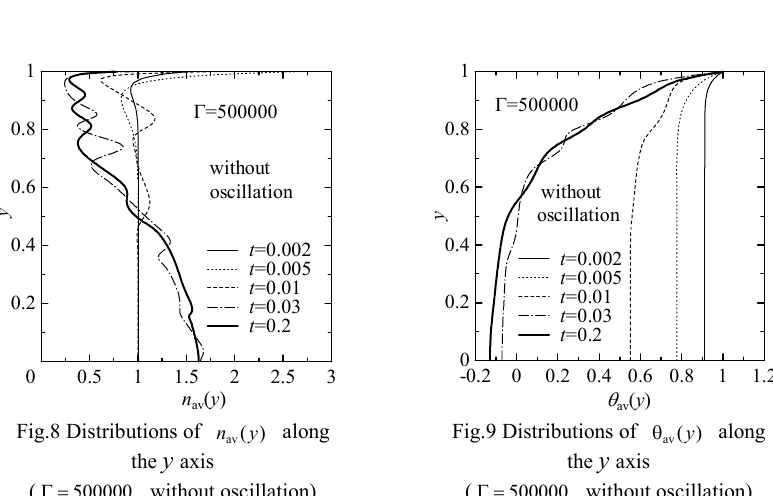
Fig.8 Distributions of )(